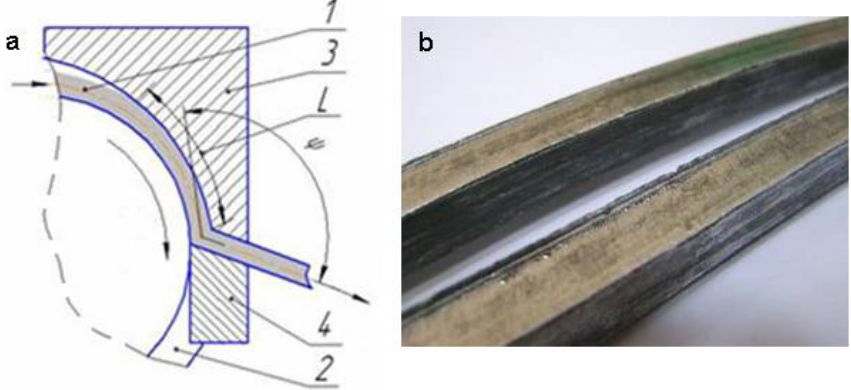
Figure 1. ( a ) A schematic illustration of ECAP-C machine: 1—ingot; 2—running wheel die; 3—pressure arrangement working surface; 4—a gauge; ψ—angle of intersection with a wheel die; L —arc of a rod grip; and ( b ) the surface of wire rods of Al 6101 alloy after six cycles of ECAP-C at 130